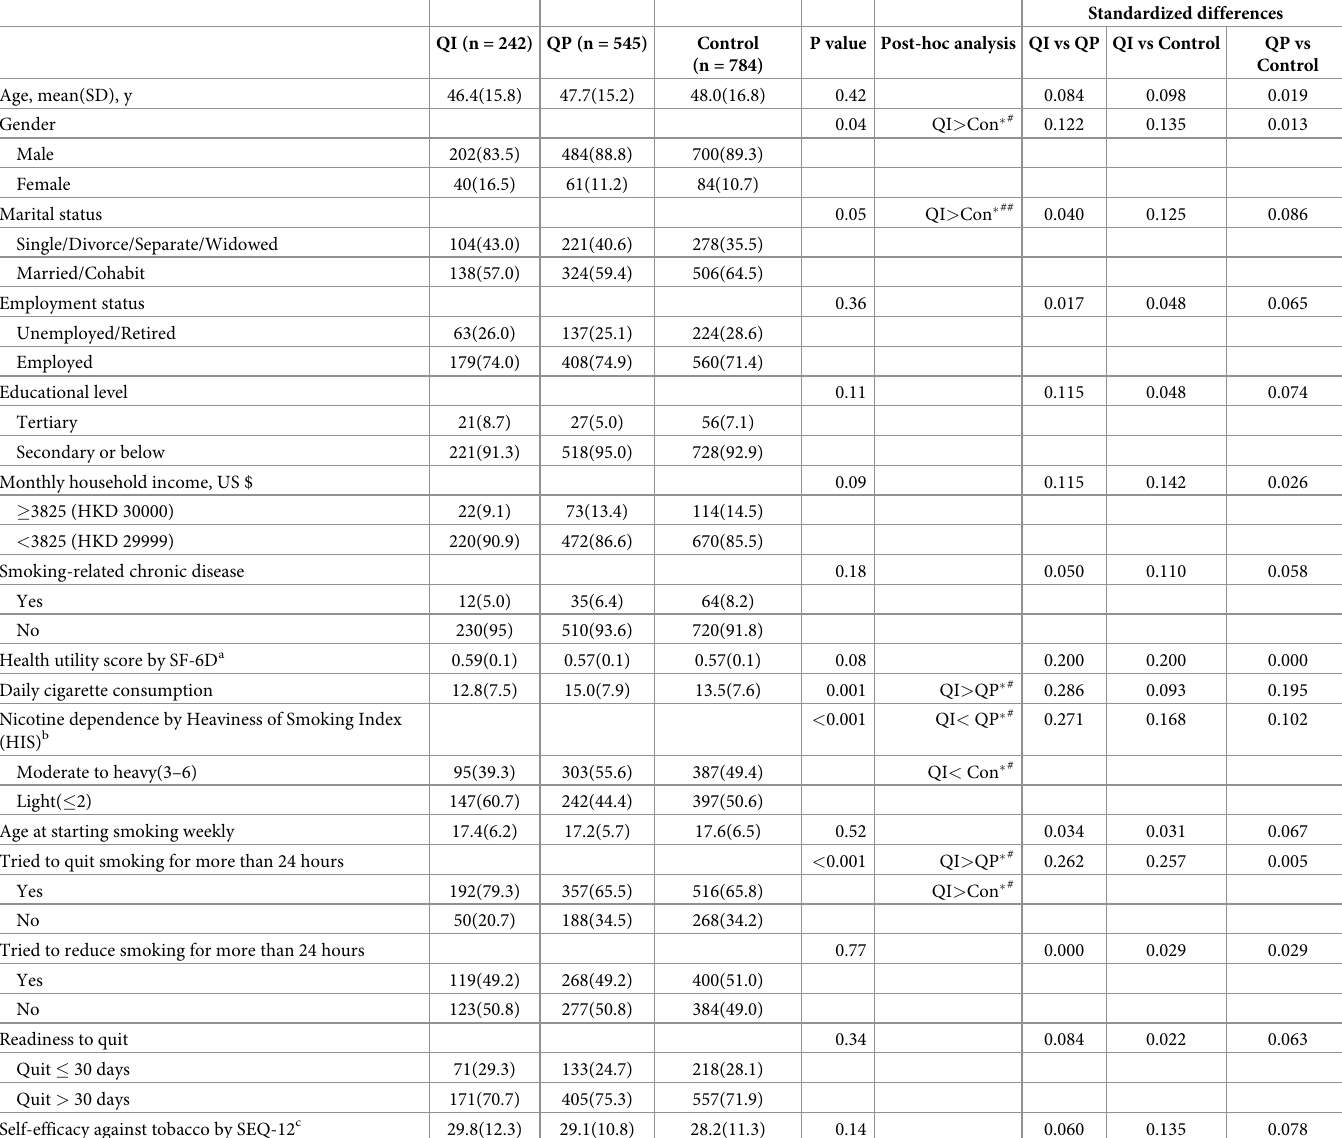
Table 1. Baseline characteristics of subjects in the Quit Immediately (QI) group, Quit Progressively (QP) group, and Control group in the original unmatched